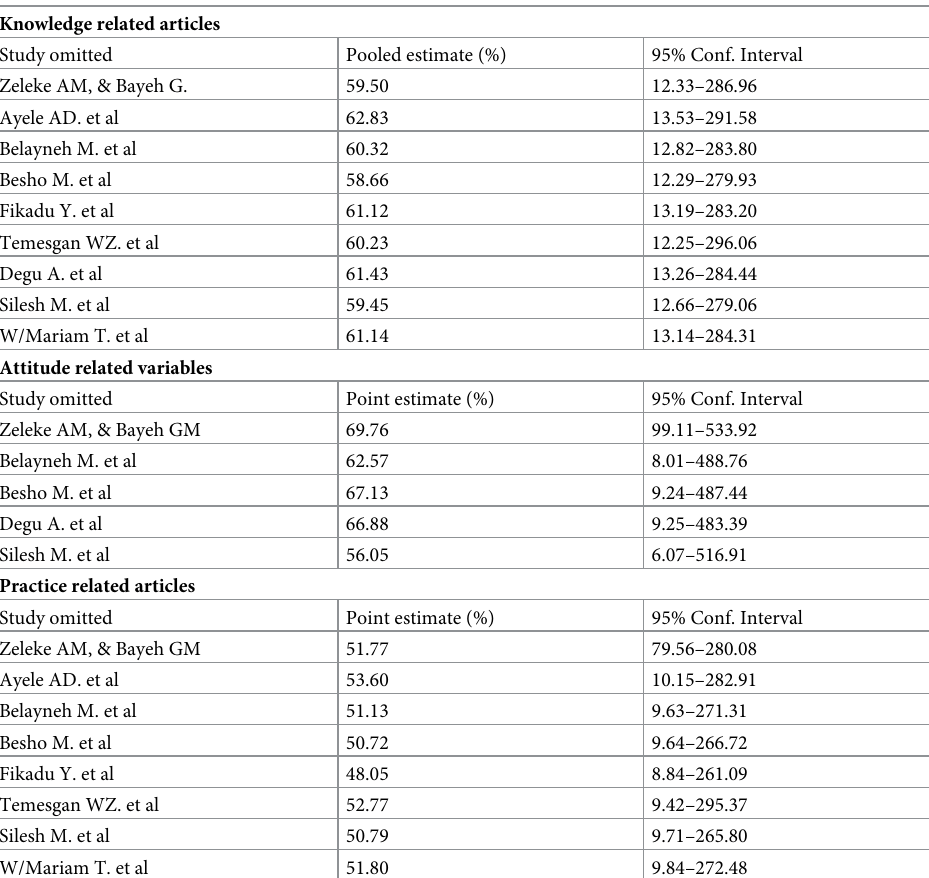
Table 3. Leave-out-one sensitivity